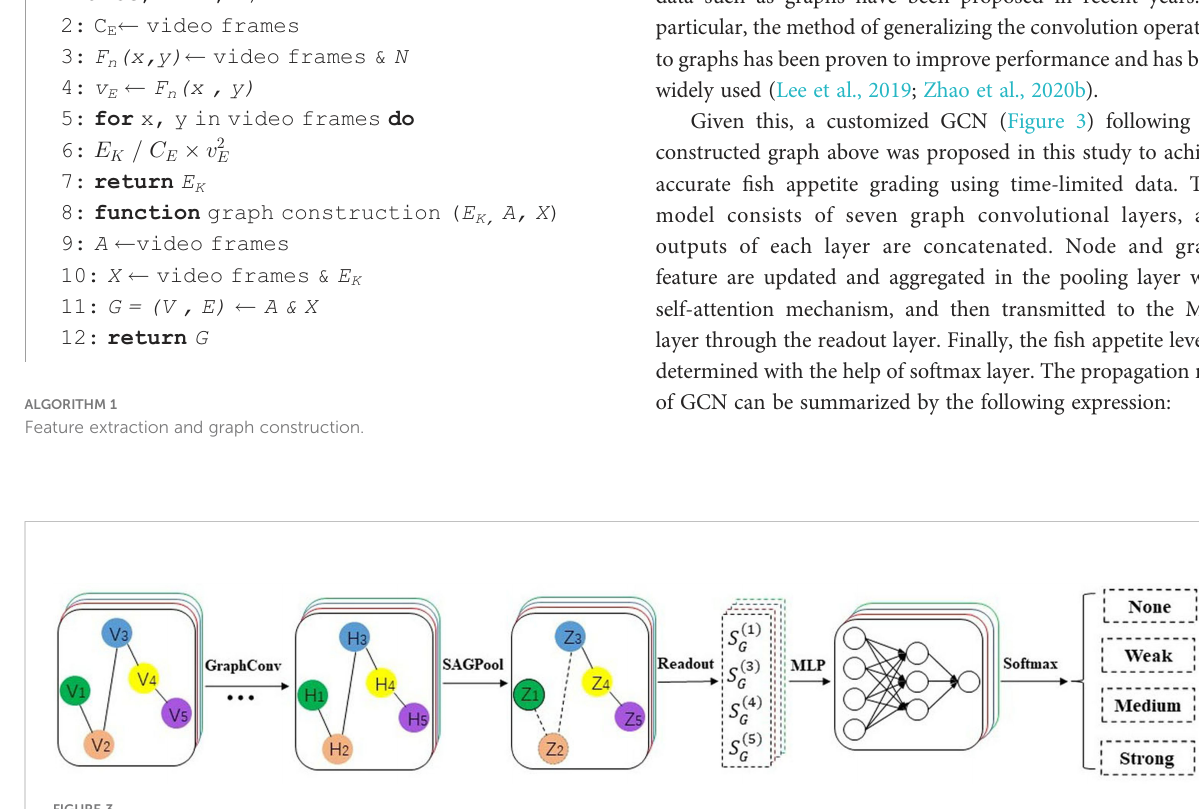
FIGURE 3 Schematic diagram of the proposed fi sh appetite grading model.